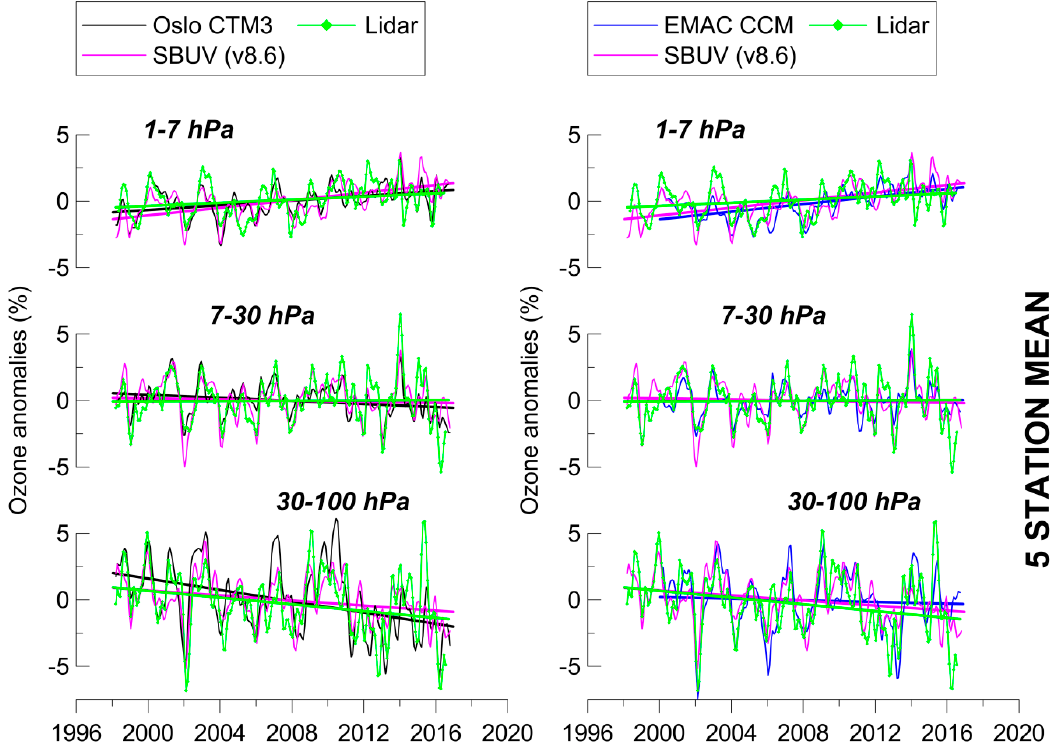
Figure 2. Comparison of CTM ozone simulations ( left ) and CCM (SC1SD-base-02) ozone simulations ( right ) with SBUV observations and lidar measurements. Shown are ozone anomalies averaged at five lidar stations (HHP–OHP–TMO–MLO–LAU), after removing seasonal and other known natural variability. For lidars, the upper stratospheric layers are confined between 3 and 7 hPa. Table 3. Statistics of correlations between ozone from Oslo CTM3, EMAC CCM (SC1SD-base-02), SBUV (v8.6) and average lidar data anomalies at five stations in the: ( a ) upper stratosphere (1–7 hPa), ( b ) middle stratosphere (7–30 hPa) and ( c ) lower stratosphere (30–100 hPa). Seasonal and other known natural variability were removed from the data. For lidars, the upper stratospheric layers are confined between 3 and 7 hPa.